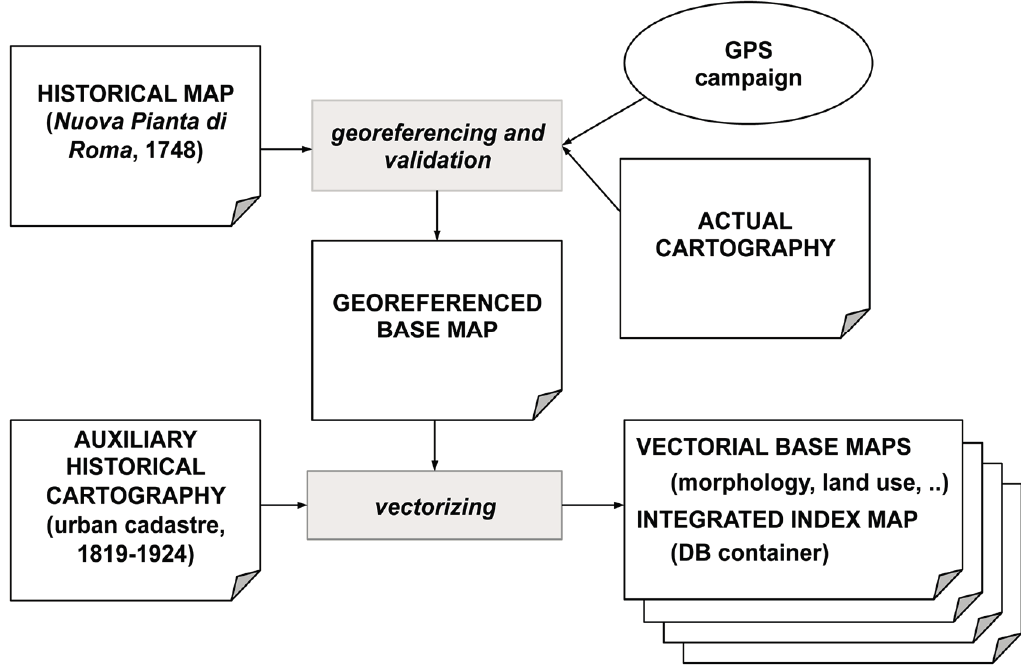
Figure 3. The historical GIS (HGIS) based on the Nuova pianta di Roma by G.B. Nolli,